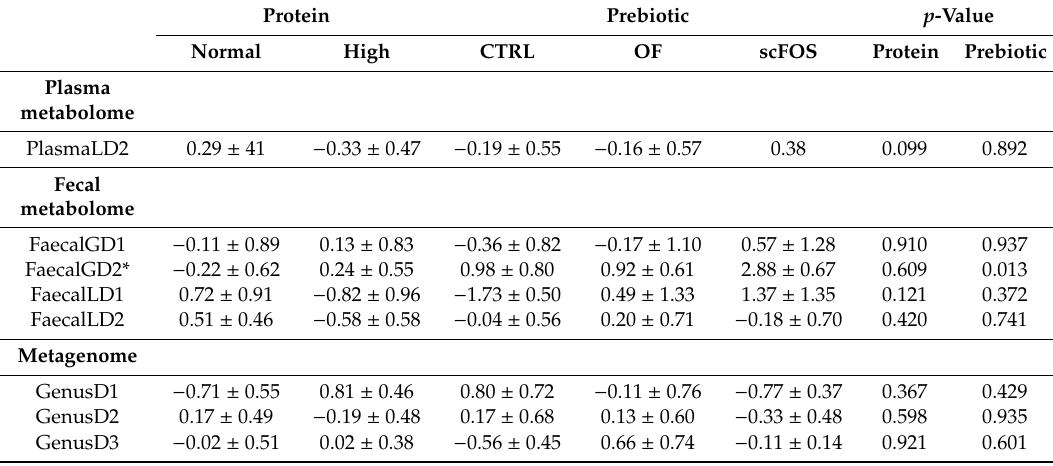
Table 6. Averaged means of microbial and metabolomic metavariables according to protein level and prebiotic supplementation. Protein Prebiotic p -Value Normal High CTRL OF scFOS Protein